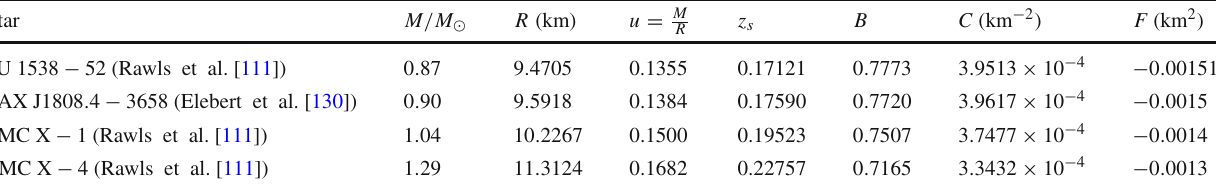
Table 1 The numerical values of constant parameters B , C and F with A = 0 . 0031 ( km − 2 ) , D = 0 . 0022 ( km − 2 ) , and β = 0 . 5, where M (cid:14) = 1 . 475